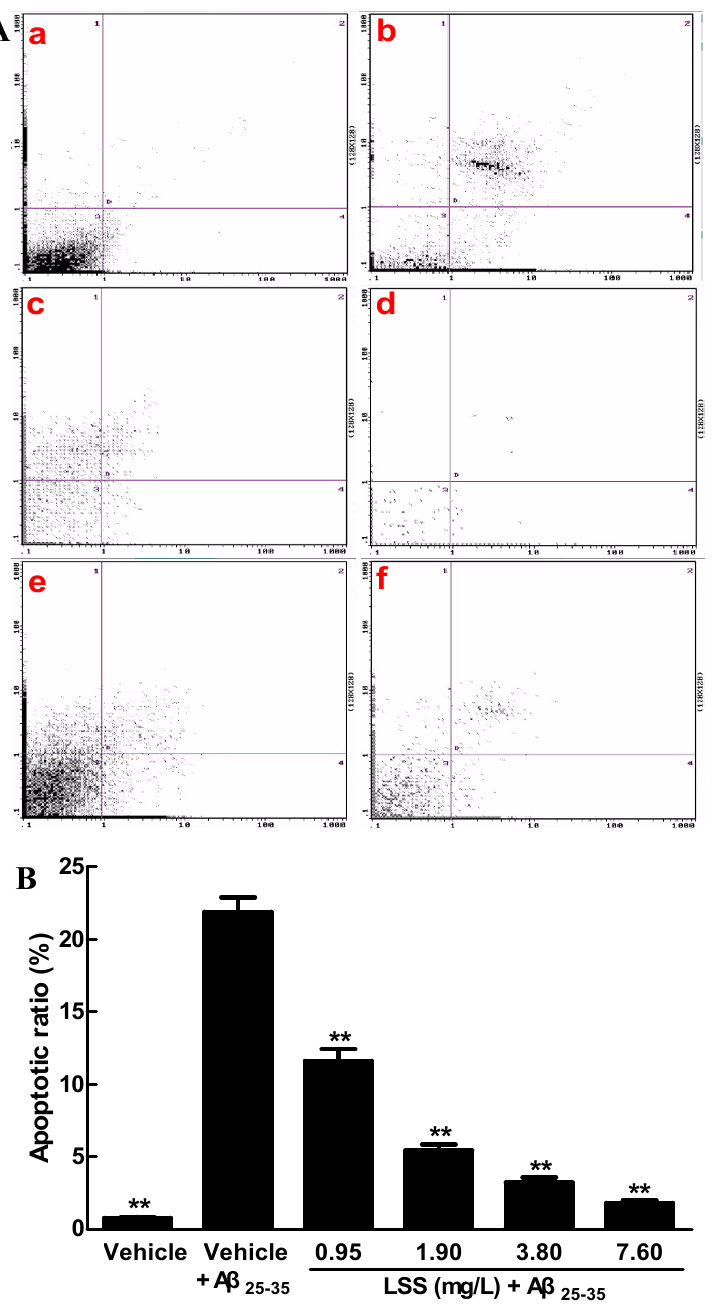
Figure 2. Effect of LSS on apoptosis ( A ) and apoptotic ratio ( B ) induced by A β 25 ‐ 35 (20 μ mol/L) in PC12 cells with Annexin V/PI staining by flow cytometric analysis. ( Aa ) Cells were treated with medium for 13 h without A β 25 ‐ 35 ; ( Ab ) cells were treated with medium for 1 h and followed by A β 25 ‐ 35 for 12 h; ( Ac ) cells were treated with LSS 0.95 mg/L for 1 h and followed by A β 25 ‐ 35 for 12 h; ( Ad ) cells were treated with LSS 1.90 mg/L for 1 h and followed by A β 25 ‐ 35 for 12 h; ( Ae ) cells were treated with LSS 3.80 mg/L for 1 h and followed by A β 25 ‐ 35 for 12 h; ( Af ) cells were treated with LSS 7.60 mg/L for 1 h and followed by A β 25 ‐ 35 for 12 h; ( B ) Summarized results of apoptotic ratio. The results are representative of at least three independent experiments run in triplicate and expressed as mean ± SD. ** p < 0.01 vs. the cells treated with vehicle and A β 25 ‐ 35 .